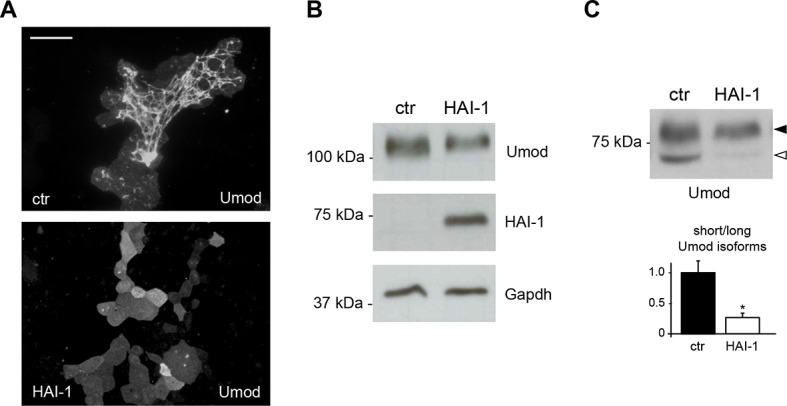
Expression of the serine protease inhibitor HAI-1 effectively reduces uromodulin cleavage at the urinary site.(A) Immunofluorescence analysis showing uromodulin on the surface of MDCK cells co-expressing the serine protease inhibitor HAI-1 (Hepatocyte growth factor Activator Inhibitor-1), as indicated. HAI-1 expression essentially abolishes uromodulin polymerisation on the cell surface. Scale bar, 50 µm. (B) Representative Western blot analysis showing uromodulin and HAI-1 expression in cell lysates of transfected MDCK cells, as indicated. Glyceraldehyde-3-phosphate dehydrogenase (Gapdh) is shown as a loading control. (C) Representative Western blot analysis of N-deglycosylated uromodulin secreted by MDCK cells co-expressing HAI-1, as indicated. Densitometric analysis (average ± s.d. of 3 independent experiments, Figure 2—source data 2) shows the ratio between the short and the long uromodulin isoforms in the absence or presence of HAI-1 co-expression, as indicated. The serine protease inhibitor HAI-1 strongly reduces the amount of the short uromodulin isoform released in the culturing medium by MDCK cells. *p<0.05 (Student’s t test).